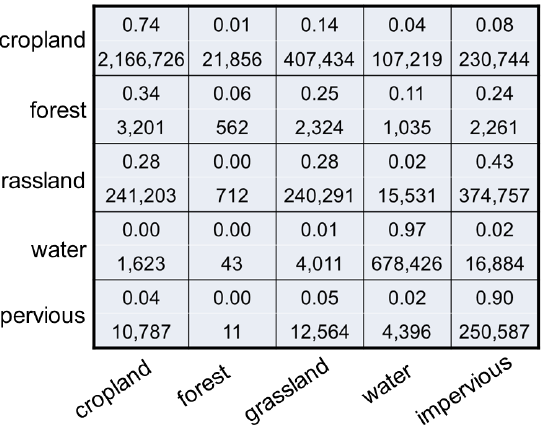
Figure 8. Confusion matrix between the CNN-dual segmentation output and the FROM-GLC land cover map at 30 m spatial resolution. The top row in each cell represents the agreement percentage and the bottom row the actual number of classified pixels. Table 6. Re-classification of CNN-dual segmentation output according to FROM-GLC nomenclature.